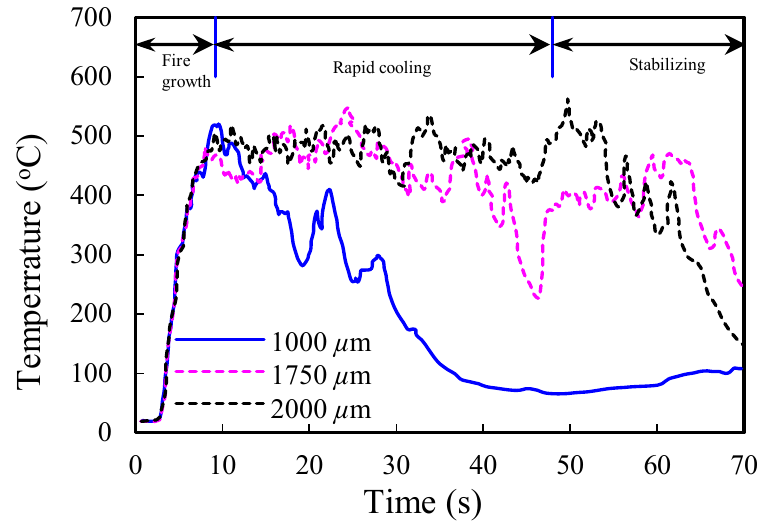
Figure 11. Time histories of temperatures for various spray nozzle droplet sizes [29]. Rapid cooling is the result of a large amount of evaporation generating steam. This steam contributes to the O 2 displacement and radiation attenuation, which are water mist suppression mechanisms. Figure 12a highlights the O 2 concentration reduction when comparing water droplet diameters of 100 µ m and 1000 µ m. Ferng [19] observed the critical cooling time for different water mist droplet sizes between 100 µ m and 1000 µ m and found that performance was better at either end of the scale, as shown in Figure